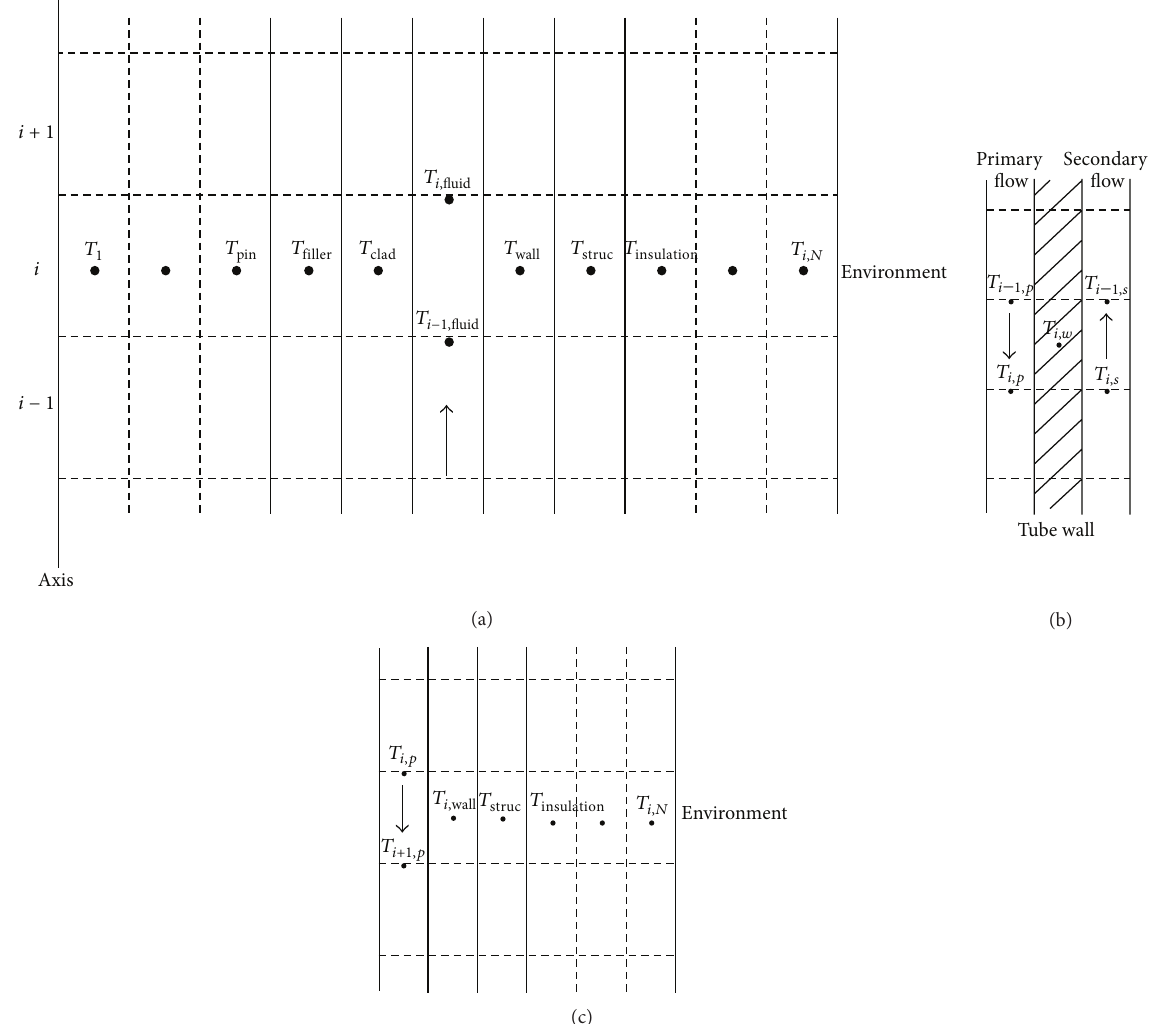
Figure 2: Calculation cells for (a) core tank model, (b) IHX model, and (c) pipe